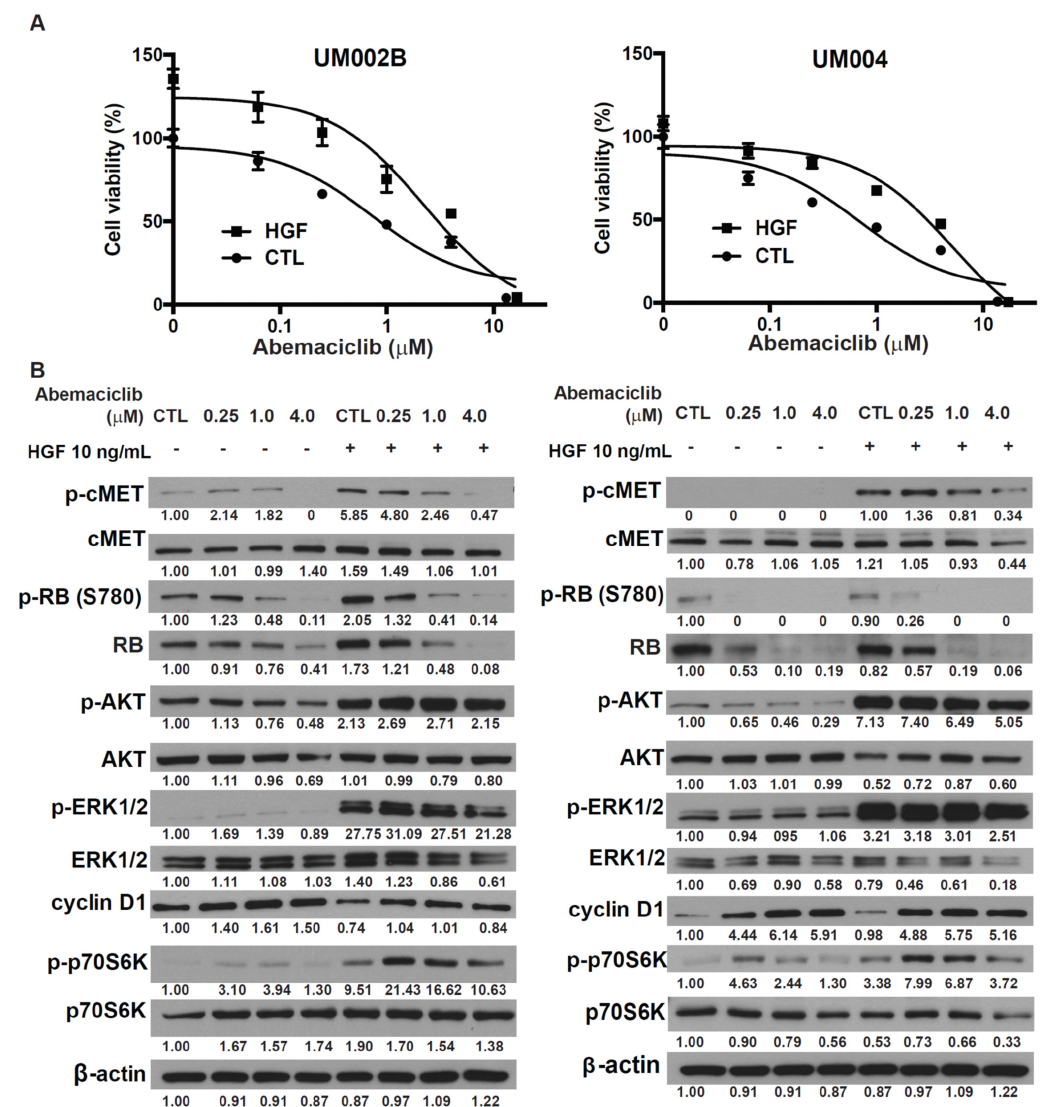
Figure 3. Hepatocyte growth factor (HGF) reduces the growth-inhibitory effect of abemaciclib in metastatic uveal melanoma cells. ( A ) Cells were exposed to various concentrations of abemaciclib as indicated with or without 10 ng/mL of HGF for 96 h and cell survival was assessed by the MTS assay. Data are presented as mean ± SD. ( B ) Cells were exposed to various concentrations of abemaciclib as indicated with or without 10 ng/mL of HGF for 48 h. Cells were lysed and phos- phorylation of cMET, RB, AKT, ERK, and p70S6K was assessed by Western immunoblotting.